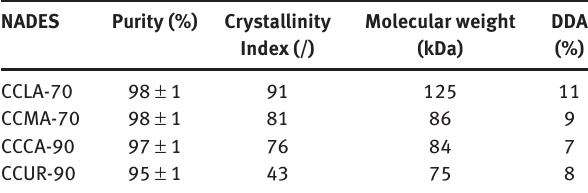
Table 2: Gravimetrically determined purity of the isolated chitin and measured crystallinity index, molecular weight and degree of deacetylation of the polymer chain.